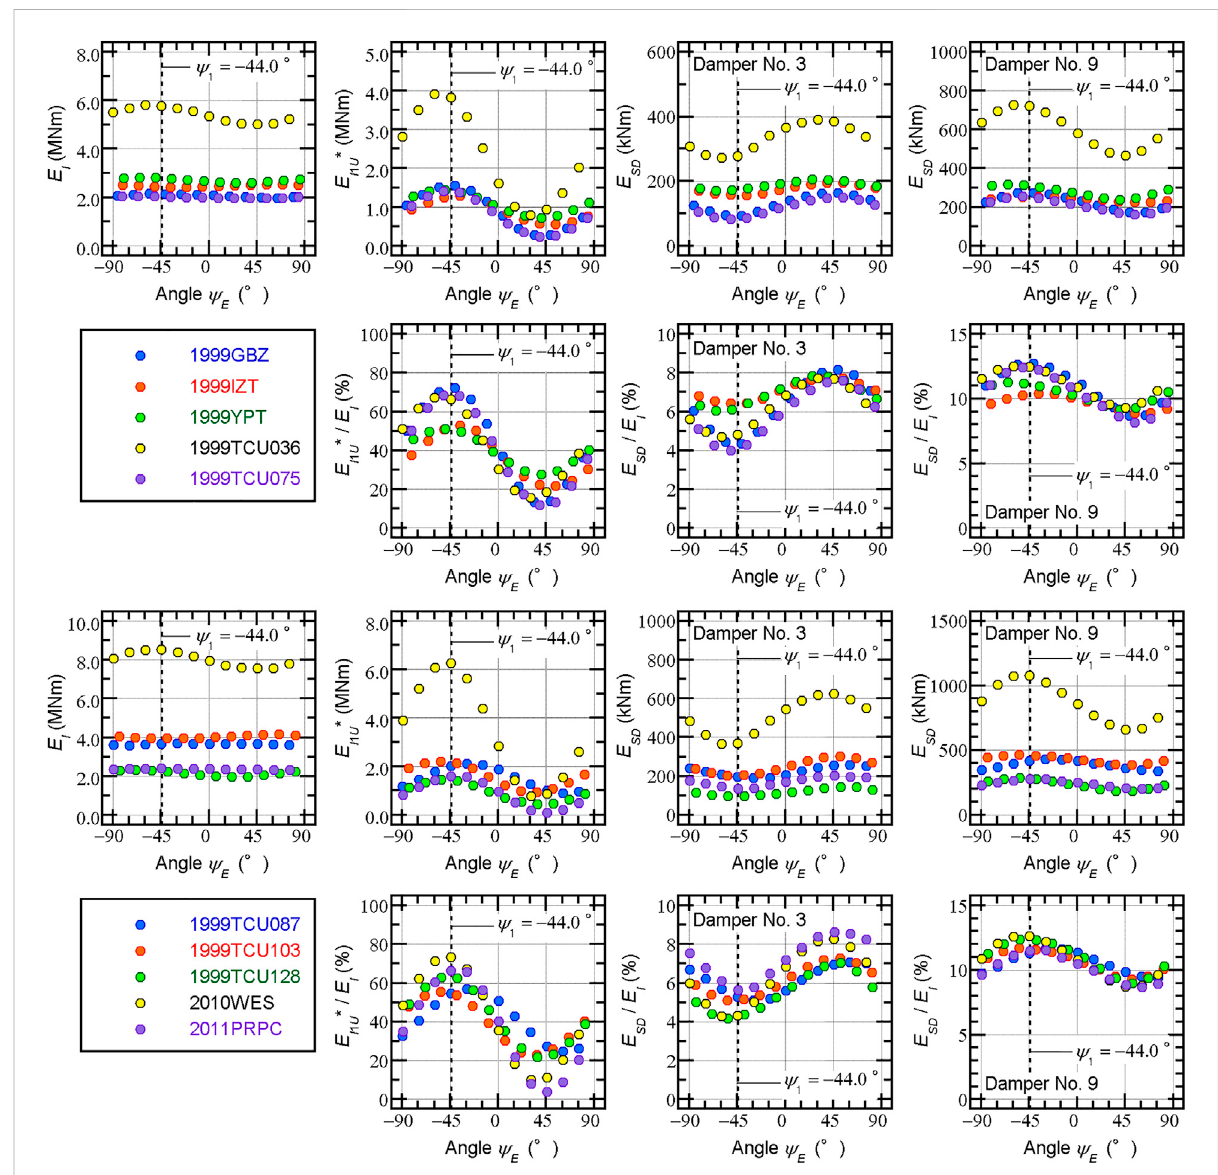
FIGURE 11 Relationship between the cumulative response and the ASI de fi ned in terms of the principal axis based on the cumulative energy input.